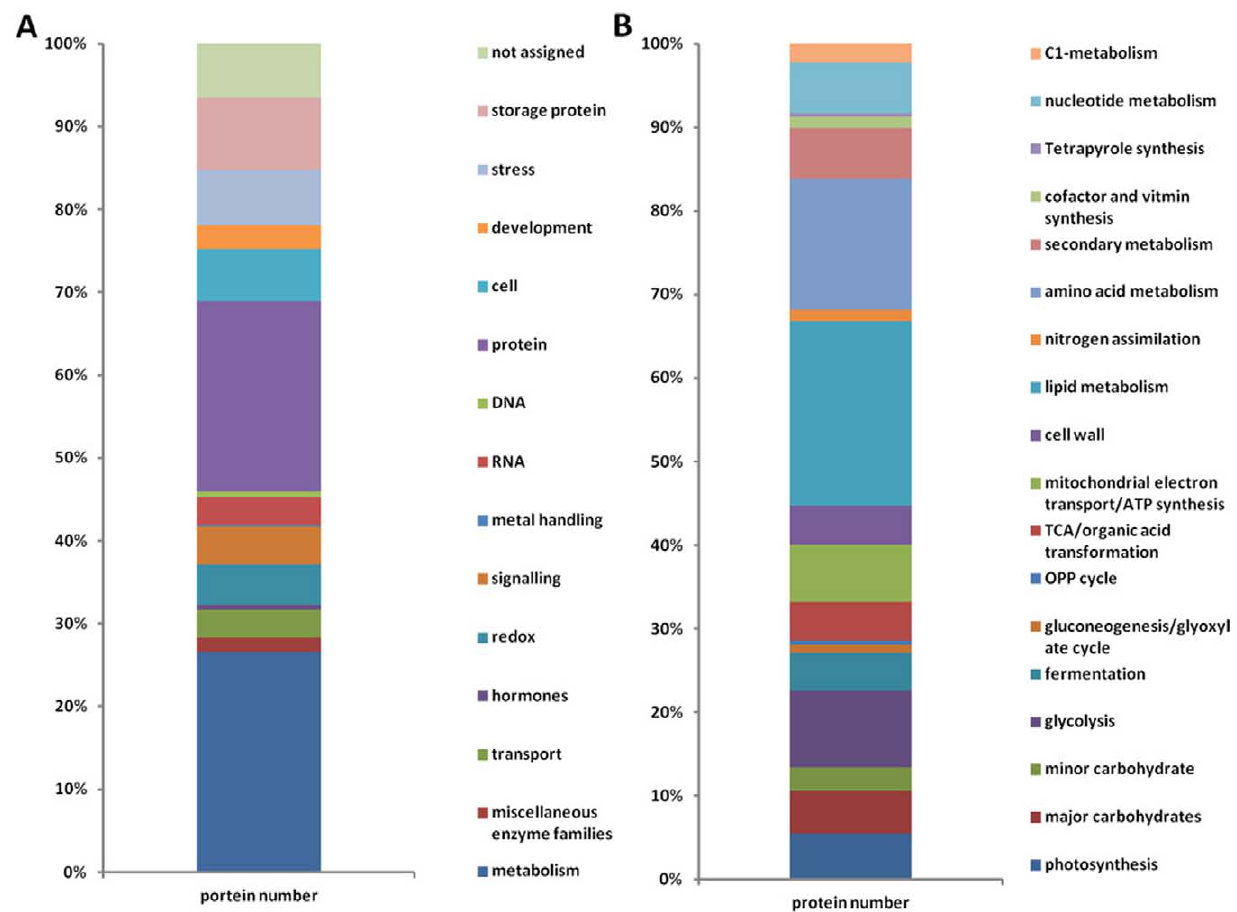
Figure 3. Functional categorization of the identified proteins. (A) total proteins; (B) the metabolism related proteins.